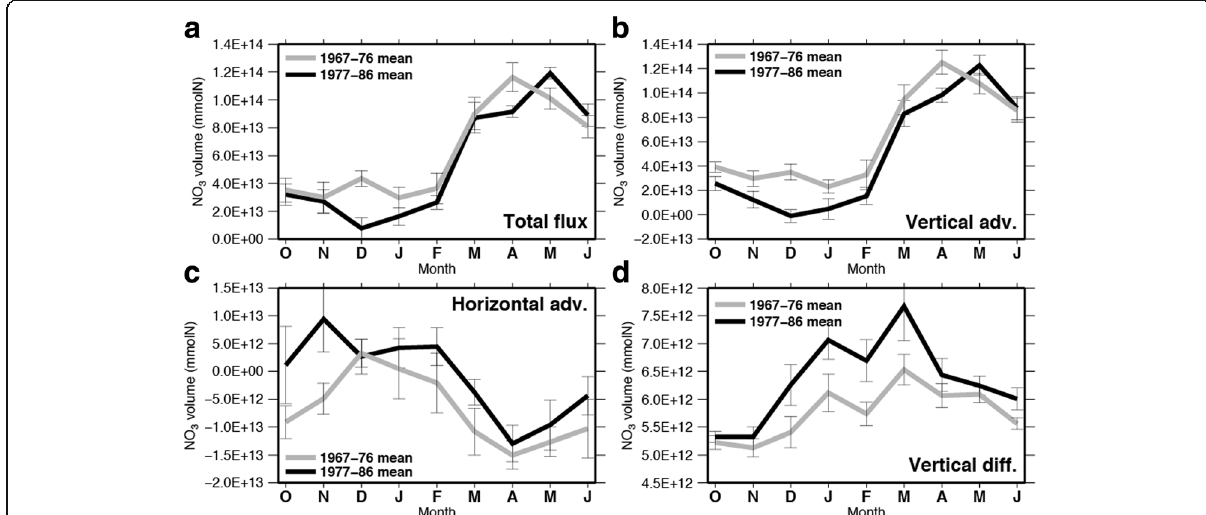
Fig. 13 Simulated seasonal changes of nitrate supply for before and after the regime shift in 1977. a Total nitrate supply, b nitrate supply by vertical advection, c nitrate supply by horizontal advection, and d nitrate supply by vertical diffusion into the coastal upper 30 m of the water column. Black line with closed circles represents 1966 – 1975 mean for October – December and 1967 – 1976 mean for January – June. Gray line with crosses represents 1976 – 1985 mean for October – December and 1977 – 1986 mean for January – June. Error bar represents the standard error. The positive/negative value denotes that nitrate increases/decreases in the coastal upper 30 m of the water column